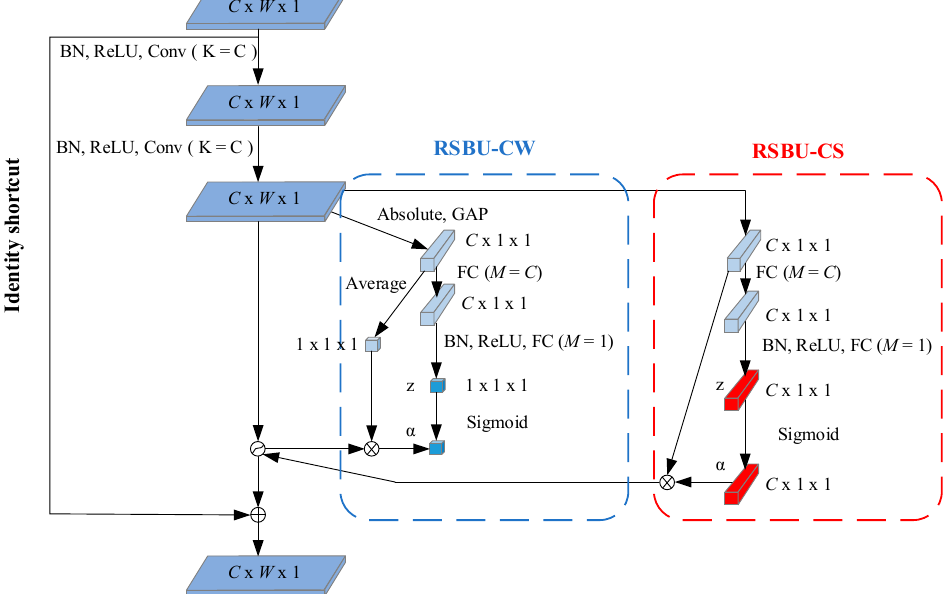
Figure 3. Structure diagram of modules RSBU-CW and RSBU-CS.